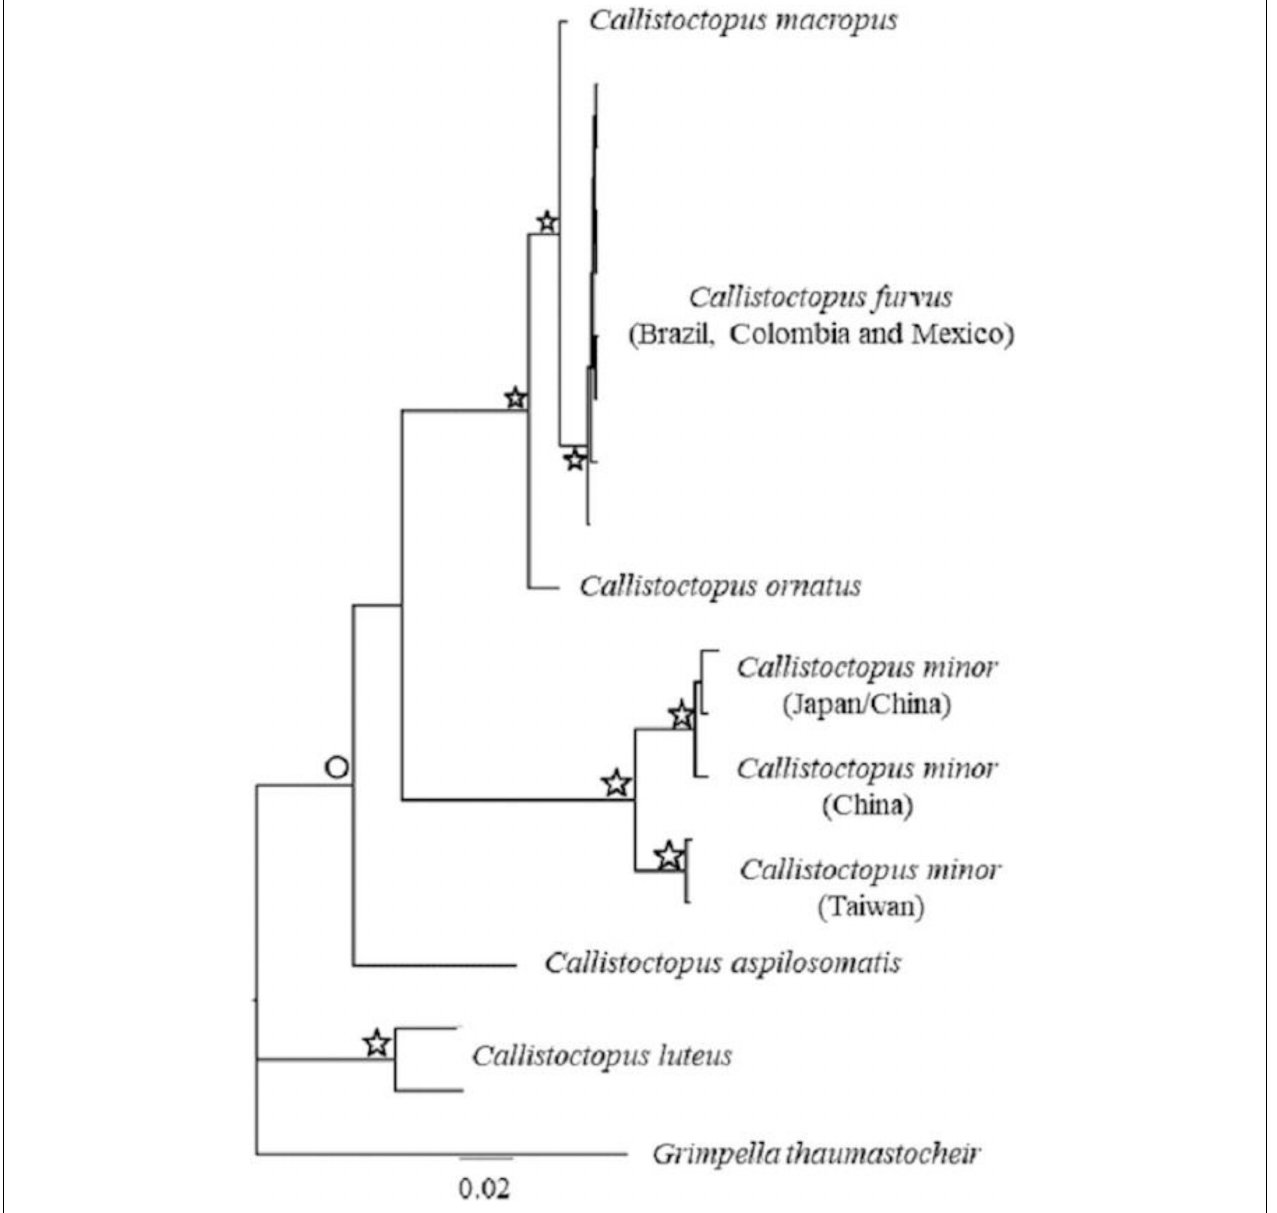
FIGURE 6 | Bayesian consensus phylogenetic tree of Callistoctopus species based on two molecular markers (16S + COI). Star denotes support values between 95% (0.95) and 100 (1) for Maximum Likelihood (ML) and Bayesian Inference (BI), respectively. Circles, denotes support values between 85% ML (0.85 BI) and 90% ML (0.9